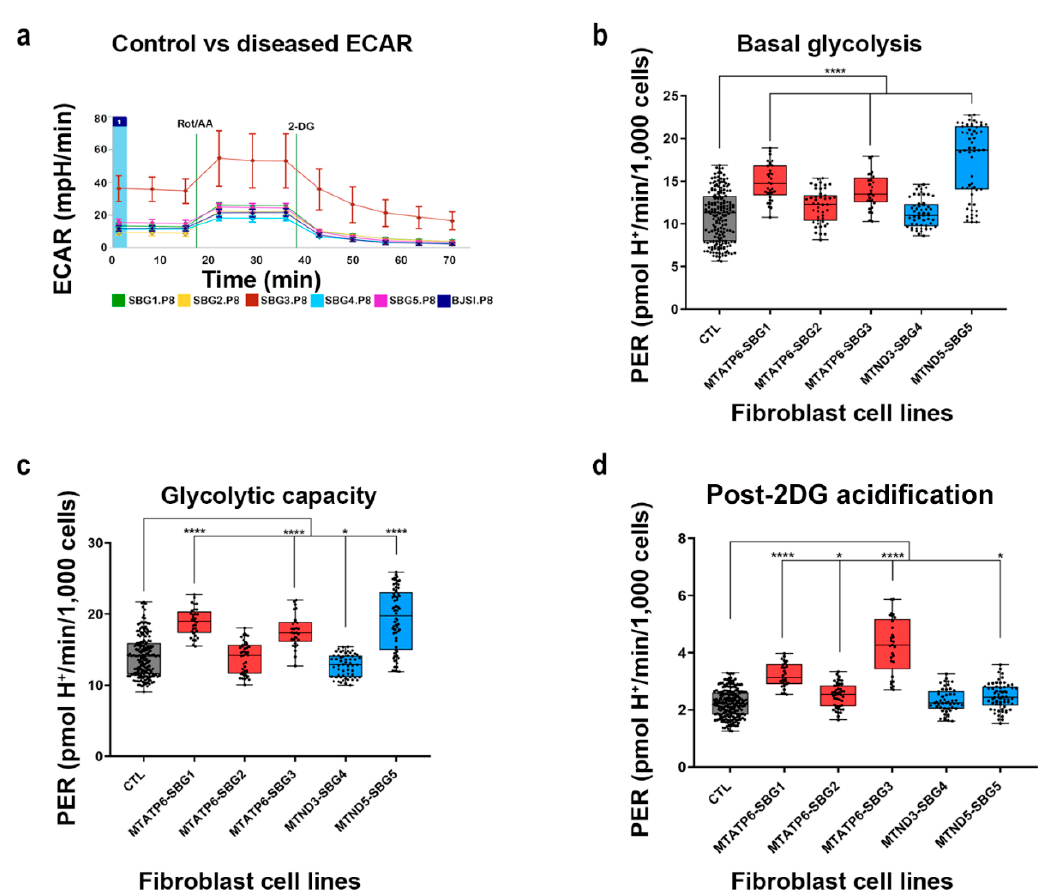
Figure 2. Glycolytic profile of CTL BJ-FB and five LS fibroblast cell lines. ( a ) a real-time profile shows the glycolytic acidification; PER of BJ-FB and diseased SBG1-FB (MT-ATP6-T8993G), SBG2-FB (MT-ATP6-T8993G), SBG3-FB (MT-ATP6- T9185C), SBG4-FB (MT-ND3-T10158C), and SBG5-FB (MT-ND5-T12706C) cell lines showing ( b ) basal glycolysis ( c ) glycolytic capacity after ETC blocking using Rot/AA ( d ) post 2-DG (non-glycolytic acidification). Data are shown in pmol H +/min/1000 cells as mean +/ − SD. Experiments were repeated at least three times on different days under the same conditions. * p < 0.05 **** p < 0.0001. Comparative analyses for all diseased (SBG1-5) FBs were conducted with the healthy control BJ-FB line. PER: proton efflux